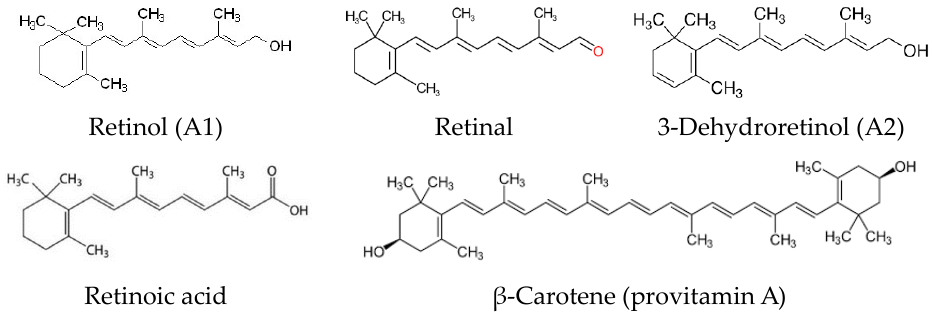
Figure 2. Structures of compounds belonging to the vitamin A group.